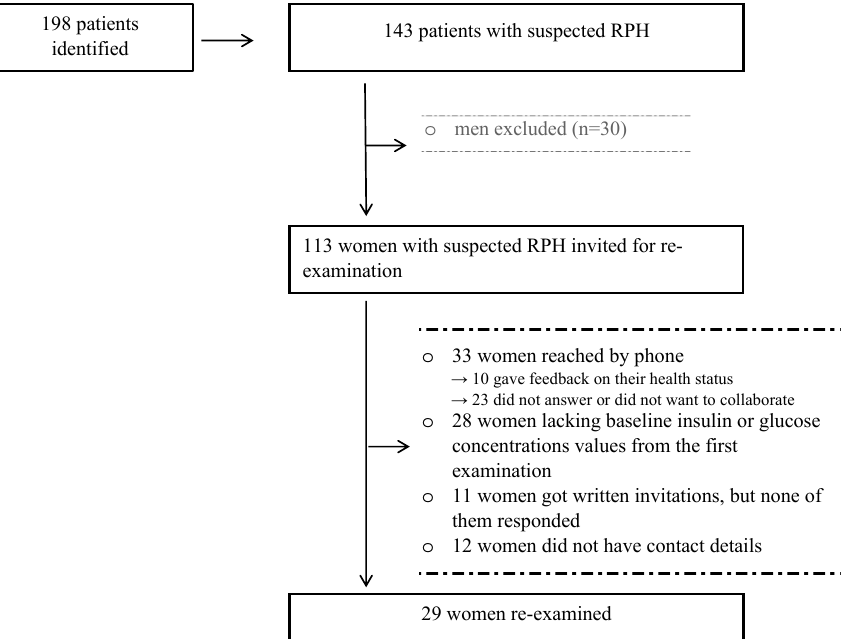
Scheme 1. Design of the study. Legend: RPH: reactive postprandial hypoglycemia.